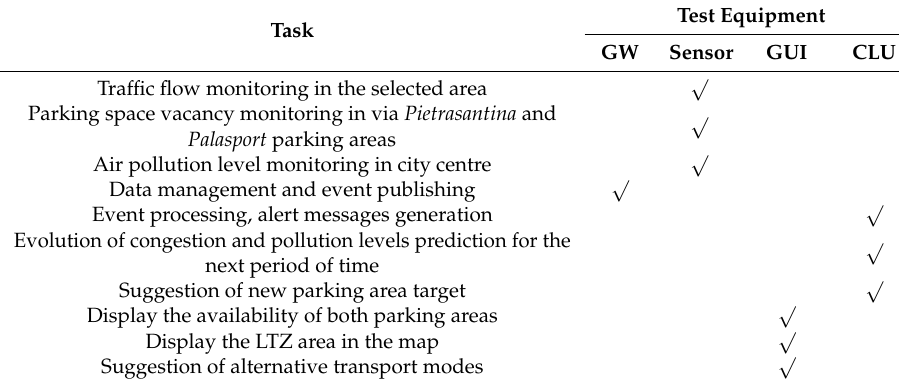
Table 3. Urban scenario related